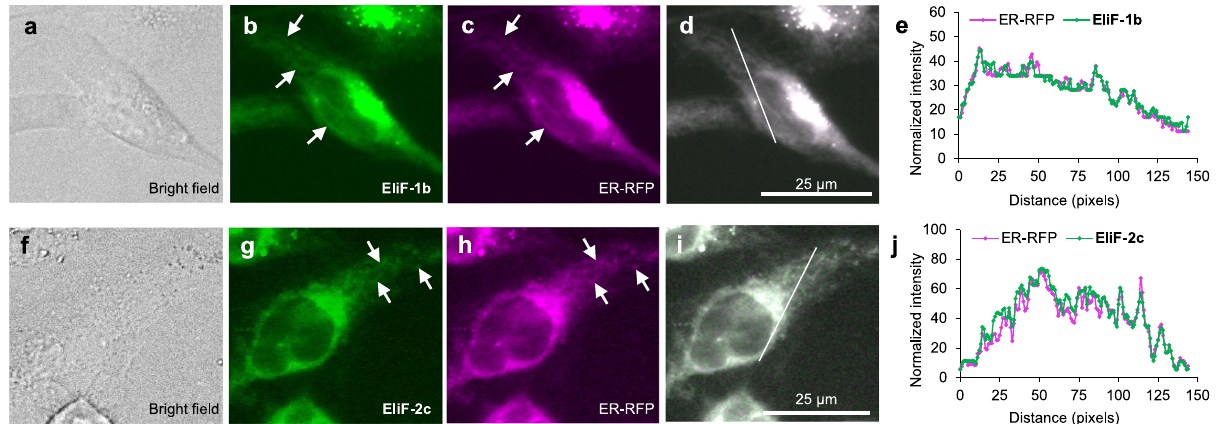
Fig. 5 | Fluorescence co-localization images of live HeLa cells stained with ER- RFP and EliF probes. Panels a – e correspond to EliF-1b ; f – j to EliF-2c (sample concentration=10 μ M; cell incubation time=30min). Panels b , g : fl uorescence images of EliF probes obtained using F1 fi lter-set ( λ exc =350/50nm, λ em =527/ 30nm). Panels c , h : fl uorescence images of ER-RFP obtained using RHOD fi lter-set ( λ exc =546/10nm, λ em =585/40nm). In panels, b , c , g , h , white arrows mark sac or